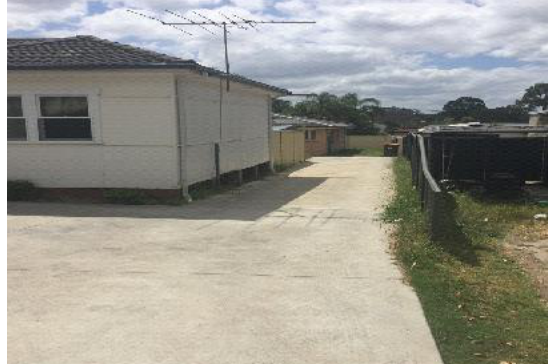
Figure 1. An example of subdivision (granny flat at the rear side of the lot) in Blacktown,